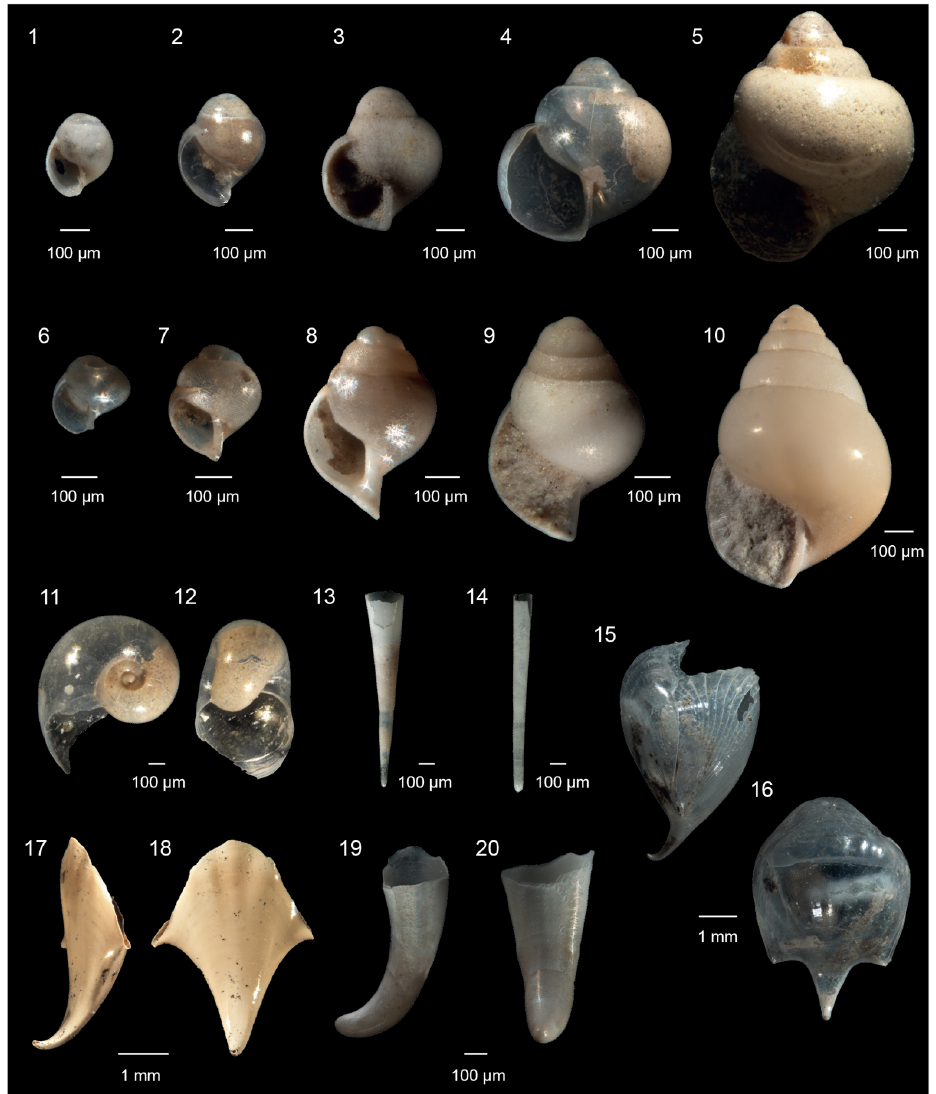
Figure 2. Pteropoda from the Levantine Basin (offshore of Israel). (1)–(5) Limacina trochiformis (d’Orbigny, 1835), from juvenile to adult specimen; (6)–(10) Limacina bulimoides (d’Orbigny, 1835), from juvenile to adult specimen; (11)–(12) Heliconoides inflatus (d’Orbigny, 1835), adult specimens, (11) spiral view, (12) aperture view; (13) Creseis conica (Eschscholtz, 1829); (14) Creseis acicula (Rang, 1828); (15)–(16) Cavolinia gibbosa (d’Orbigny, 1835), adult specimens, (15) side view, (16) ventral view; (17)–(18) Cavolinia inflexa , adult speci- mens, (17) side view and (18) dorsal view; (19)–(20) Cavolinia spp. protoconch, (19) side view and 20 dorsal